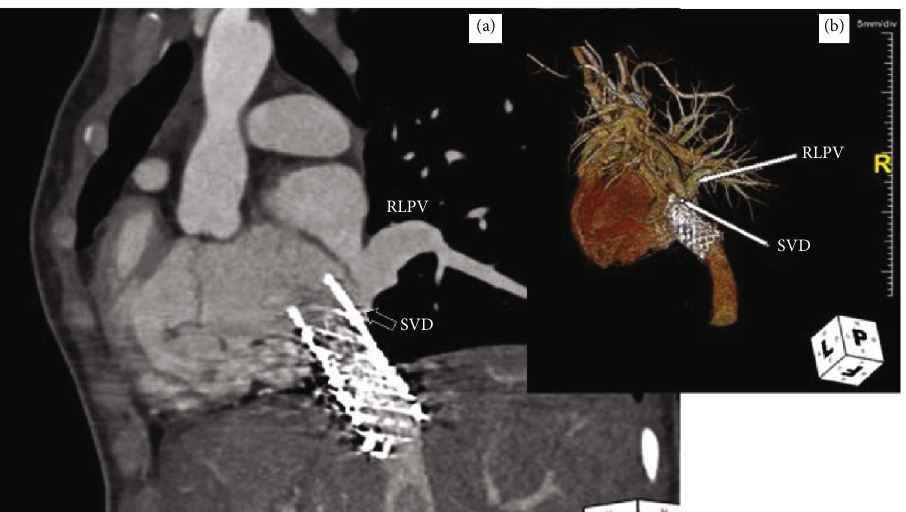
Figure 17: Postprocedural computed tomography angiogram showing (a) a sagittal image and (b) a rendered image of a patent 3-stent structure in the inferior vena cava. The stent structure covers the sinus venosus defect (SVD) with the upper end almost opposed to the interatrial septum causing a small residual opening (black arrow) and unobstructed blood fl ow from the right lower pulmonary vein (RLPV) to the left atrium (a). The superior segment of the covered stent should be fl ared by balloon to prevent residual